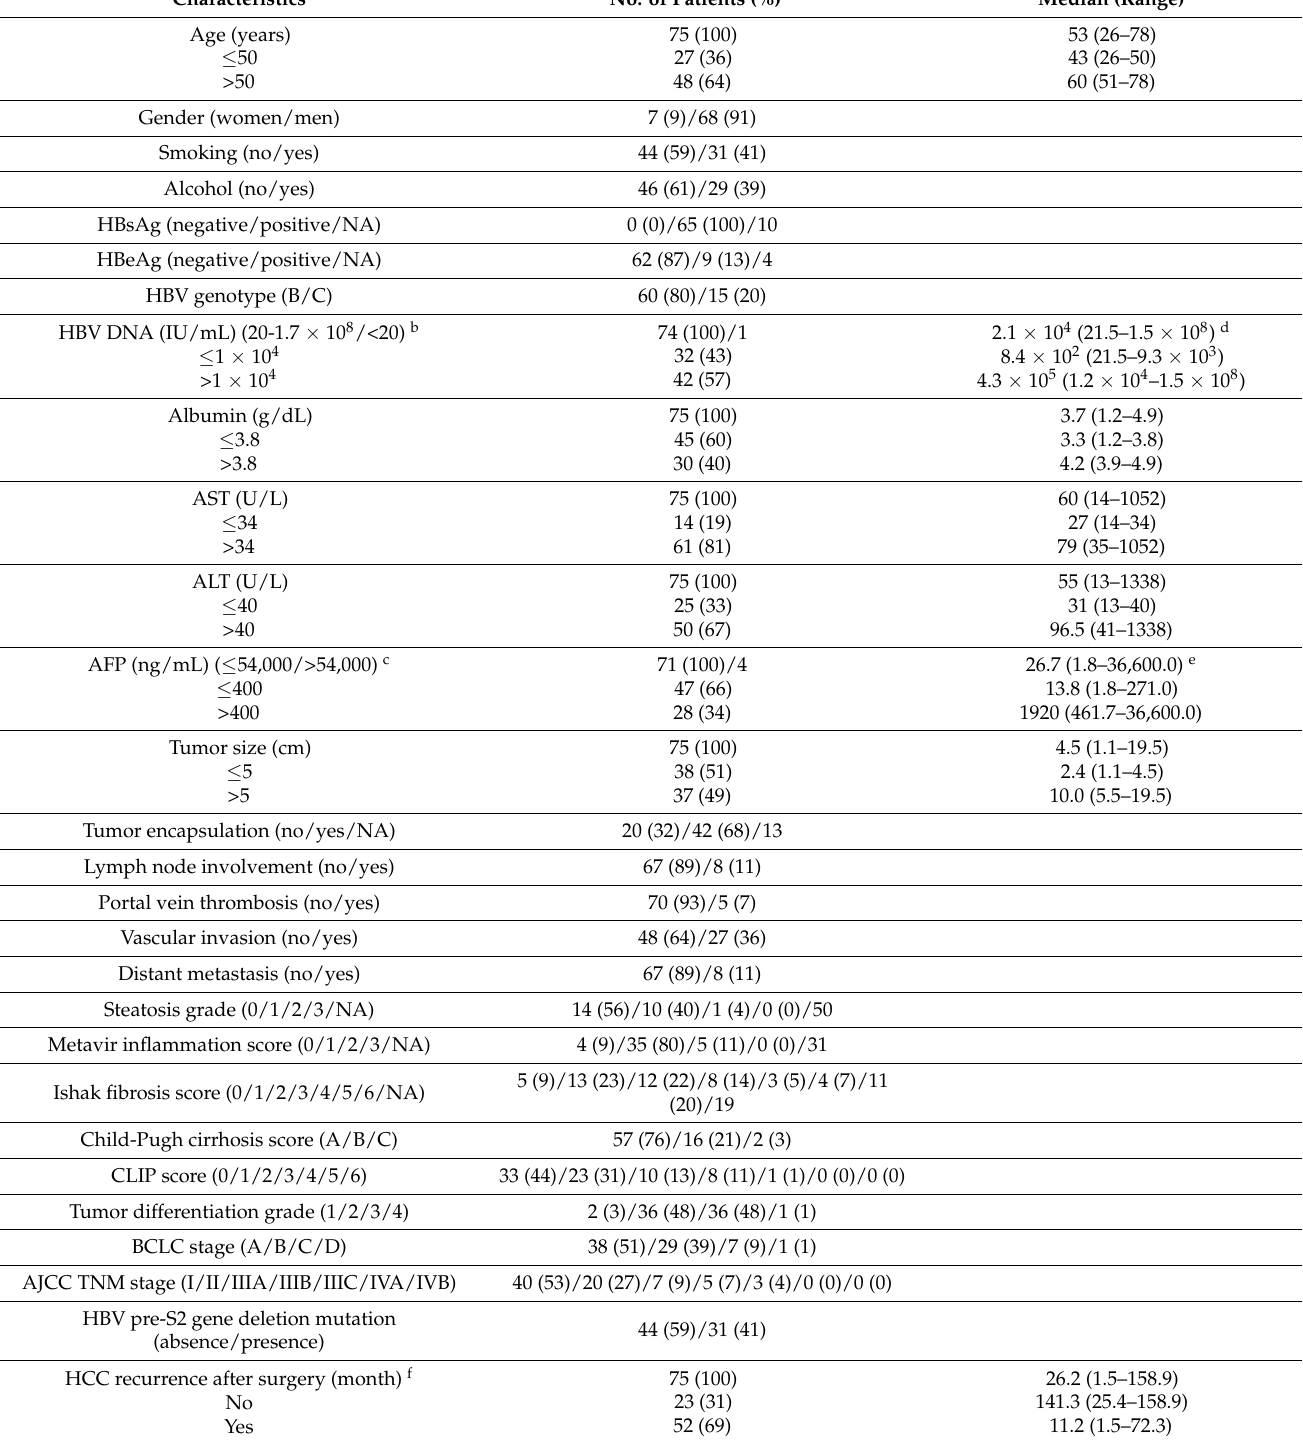
Table 1. Clinicopathological profile of 75 HBV-related HCC patients enrolled in this